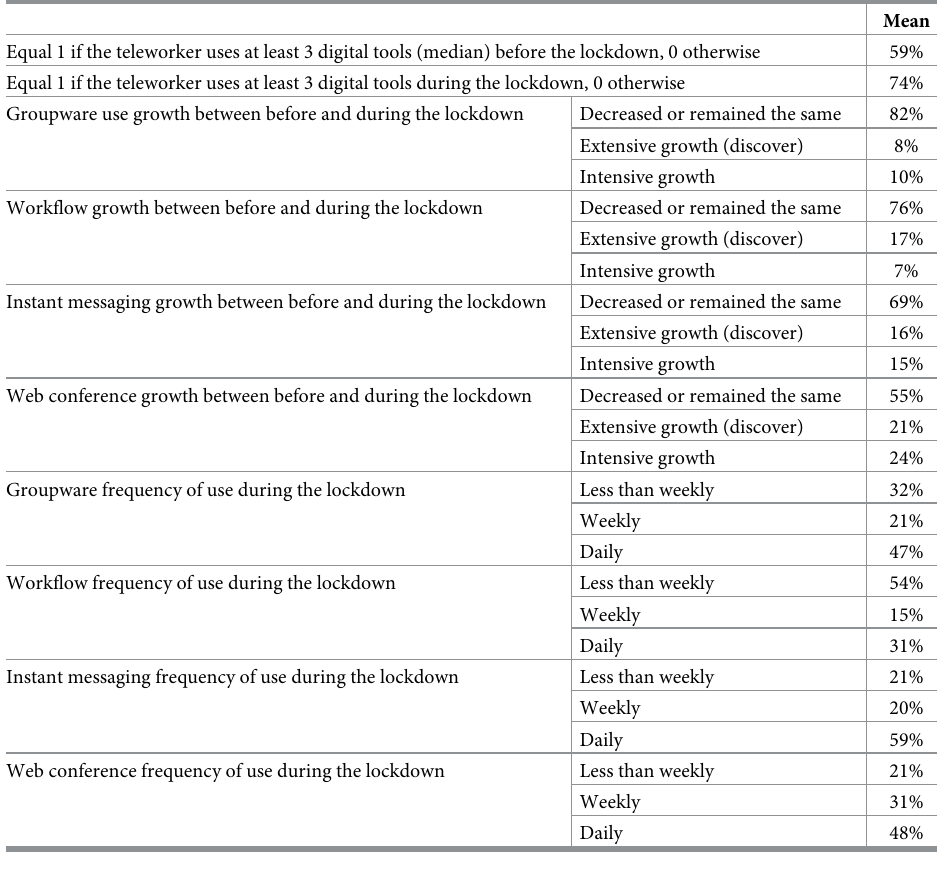
Table 1. Use and intensity of use of digital tools.